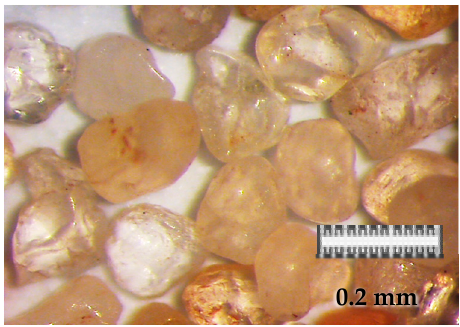
Figure 9. Shape and size of abrasive material.